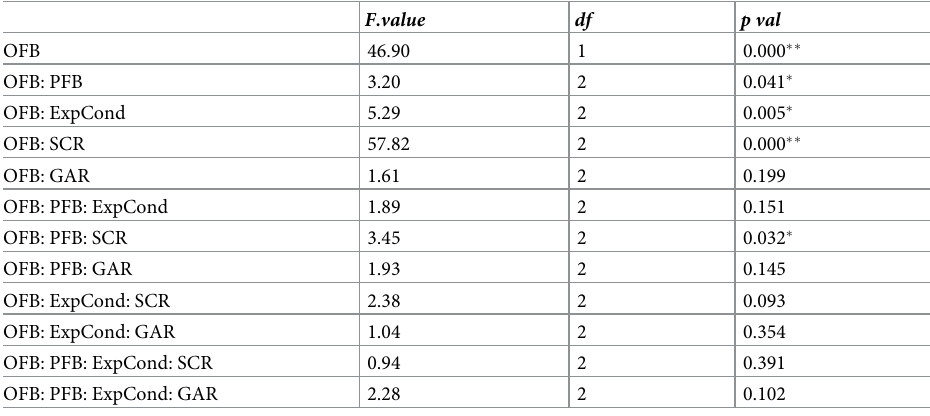
Table 6. Summaries of the type III analysis of variance for gain- and loss-related P300. F .